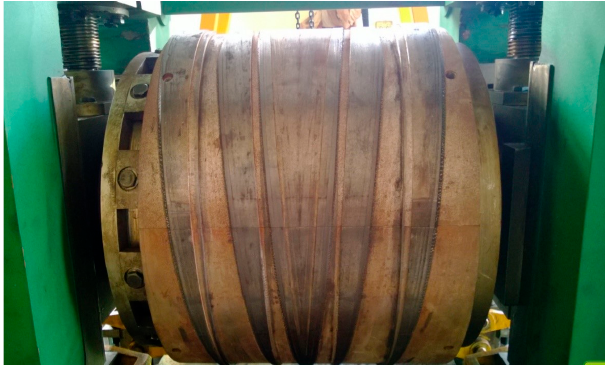
Figure 5. Die of MSCWR.